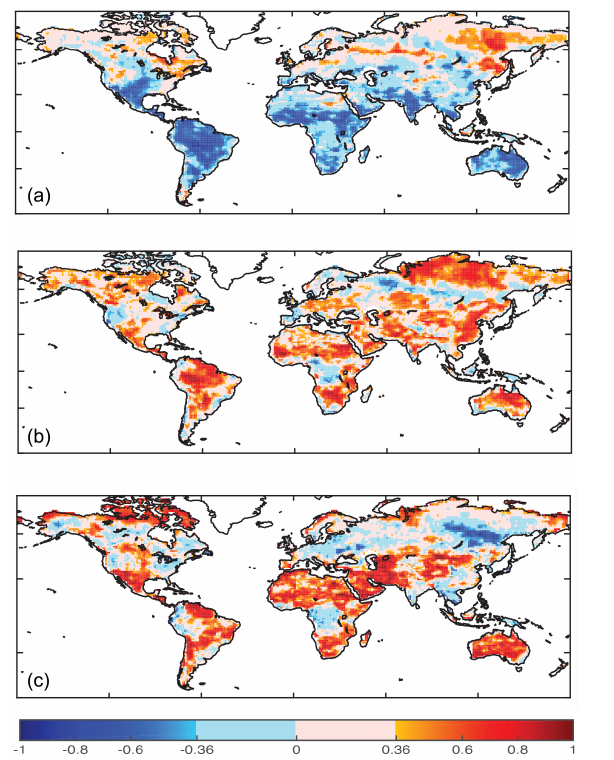
Figure 6. Rank correlation across models at every grid box of the mean model change in LAI (2081–2100 minus 1981–2000) for RCP8.5 against the model change over the same time period of tem- perature (a) , precipitation (b) and vegetation carbon stock (c)